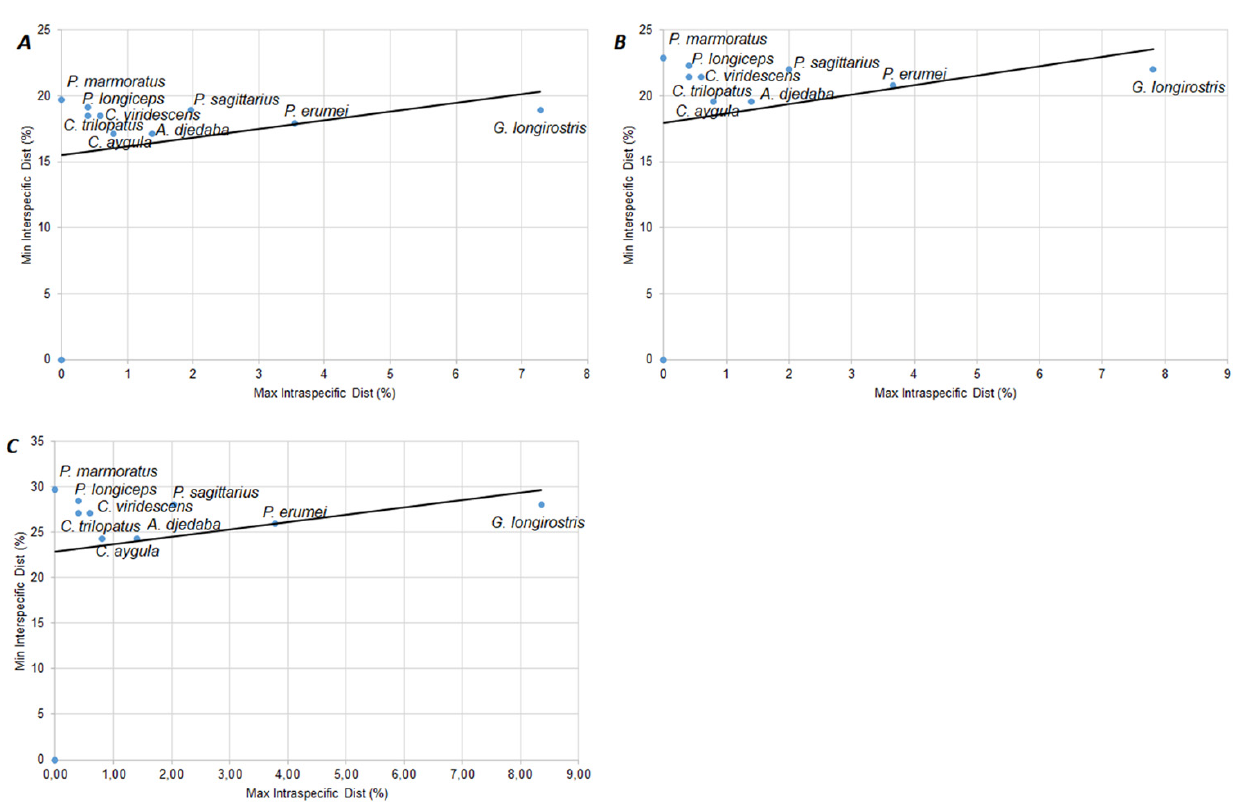
Fig. 3. Analysis of barcoding gap using the models Jukes-Cantor (a), p-distances (b) and Kimura-2 Parmeters